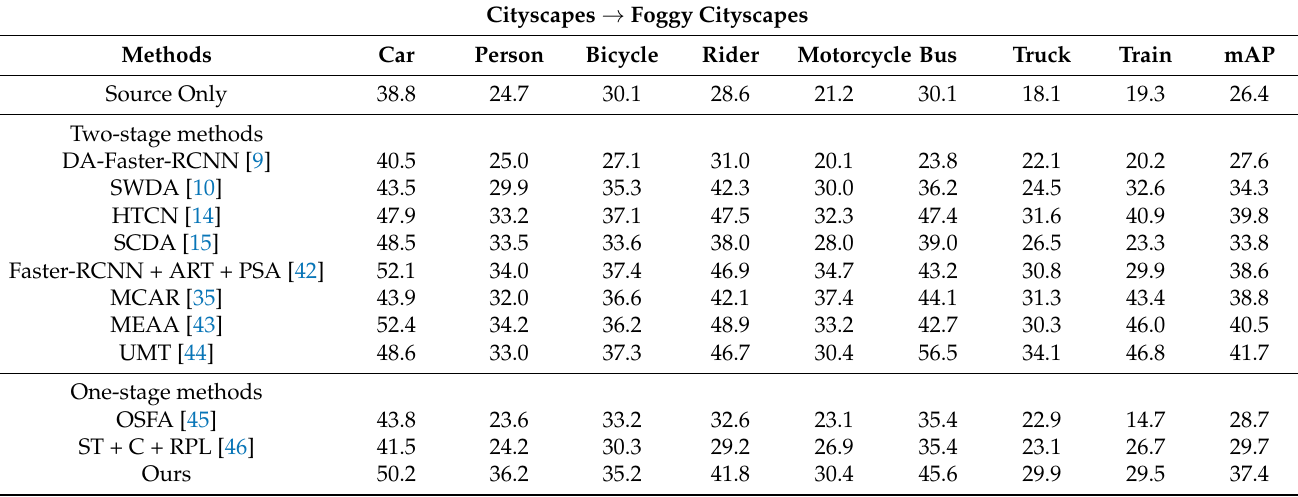
Table 1. Weather adaptation: results on adaptation from Cityscapes to Foggy